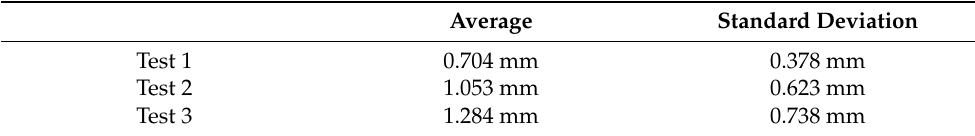
Table 2. RealSense D435 evaluation to perform a 3D reconstruction.